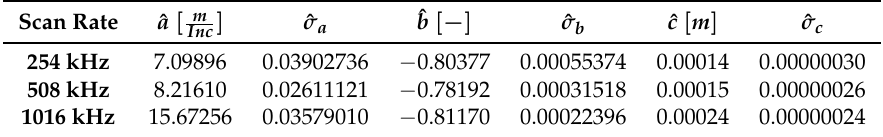
Table 4. Estimated parameters of the intensity-based stochastic models for the Z + F Profiler 9012A. Scan